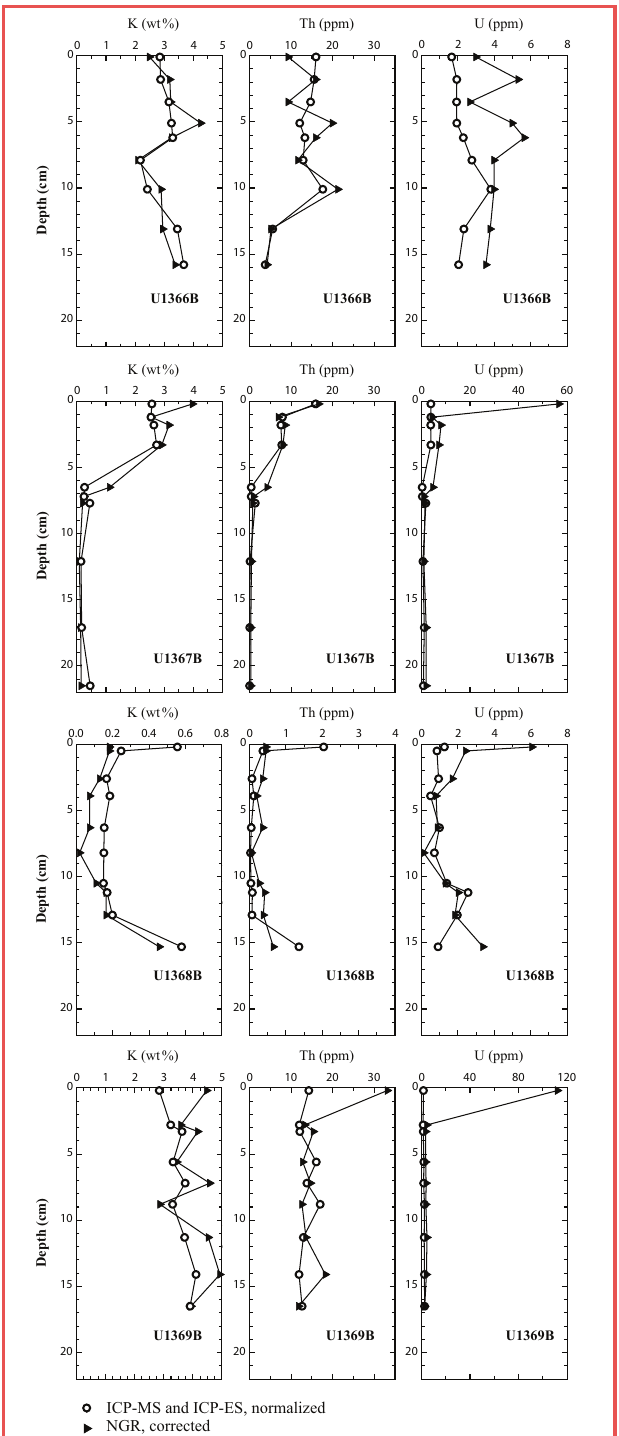
Figure 4. Depth profiles of the concentrations of K, Th, and U for Holes U1366B, U1367B, U1368B, and U1369B showing ICP-MS and ICP-ES data (circles) and NGR density-corrected data (triangles). Additional NGR total cps data from Expedition 329 (not shown here) illustrates a more continuous equilibration trend from the highest NGR emitted from sediment at the sediment-water interface and declining with